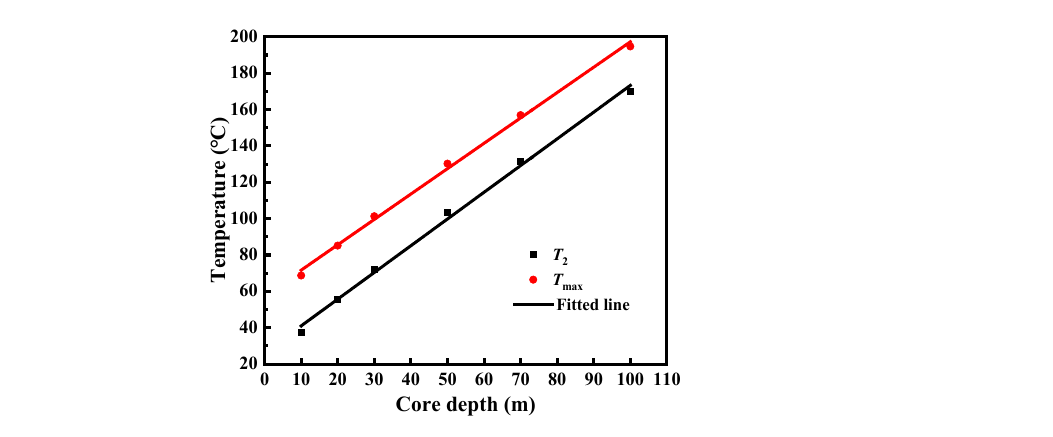
Figure 15. Temperature of measuring point at different core depths in JLS. T 2 is the temperature of measuring point at the end of the second stage; T max is the maximum temperature of measuring point during coring.